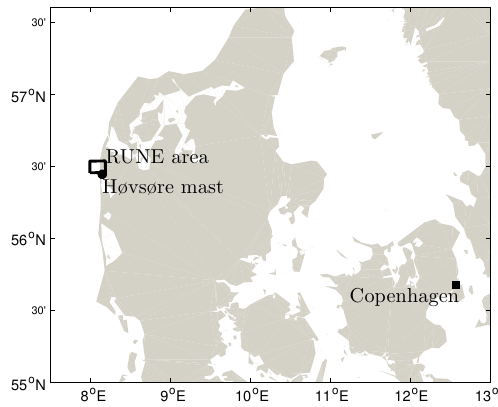
Figure 1. The RUNE experimental site in Denmark. The area of the coastal experiment is shown with the rectangle, and the positions of the meteorological mast at Høvsøre with the circle marker and Copenhagen with the square